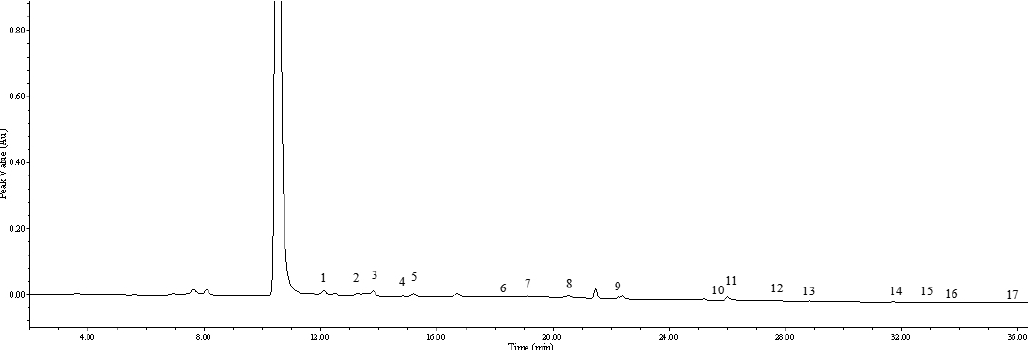
Figure 2. HPLC chromatogram of amino acids in Gonostegia hirta : 1. Asp; 2. Ser; 3. Glu; 4. Gly; 5. His; 6. Arg; 7. Thr; 8. Ala; 9. Pro; 10. Cys; 11. Tyr; 12. Val; 13. Met; 14. Lys; 15. Ile; 16. Leu; and 17. Phe.